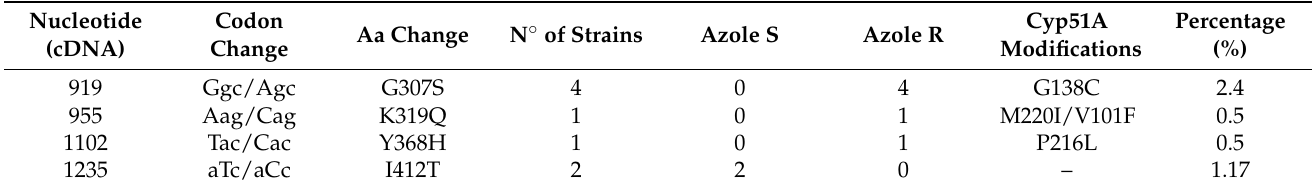
(Table 3): G307S in four azole-resistant strains with underlying Cyp51A mutations, K319Q and Y368H in azole-resistant strains with Cyp51A azole resistance mechanisms and I412T in two azole-susceptible strains. Results from the analysis of the complete sequence of hmg1 have been previously published [34] and are summarized in Table S1. Table 3. Analysis of the Hmg1 amino acid substitutions found in our set of 170 A. fumigatus clinical strains. Only substitutions found inside the SSD are listed. Concomitant Cyp51A azole resistance mechanisms are also shown.